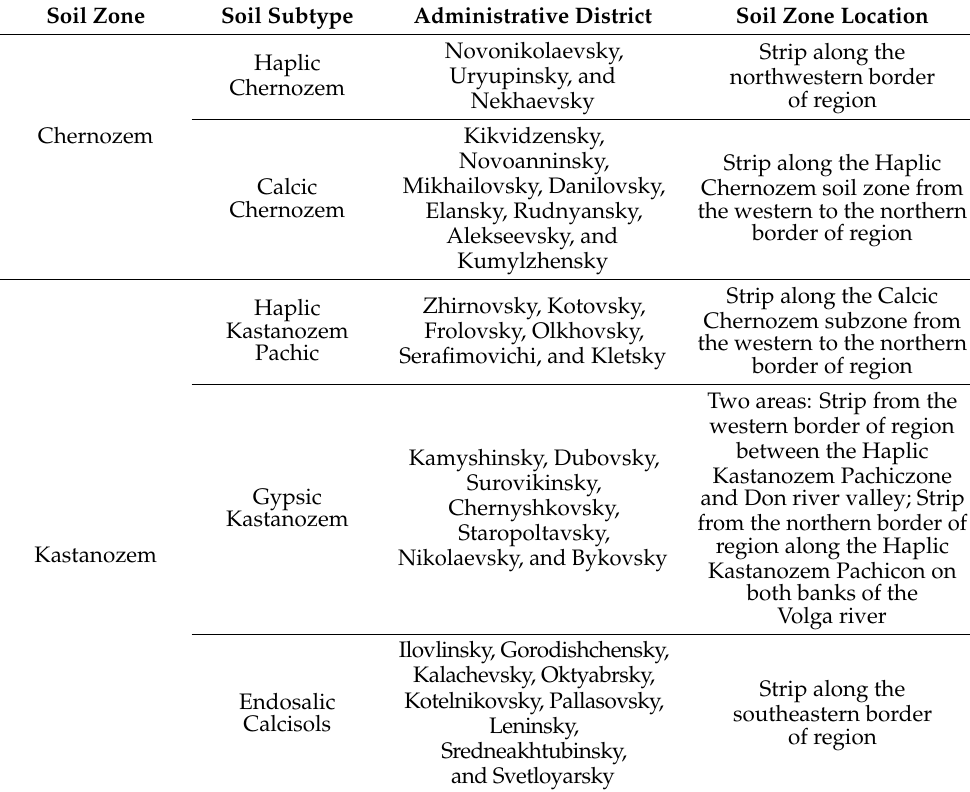
Table 4. Volgograd region main soil zones